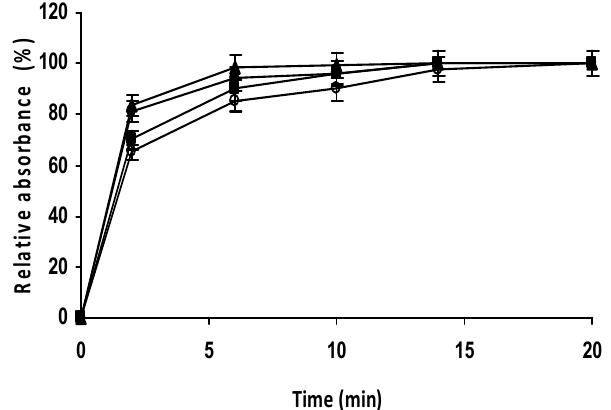
Figure 14. Operational stability of rAaeUPO immobilized on MANAE support. The reaction was performed for 20 min in 5 mM sodium acetate containing 0.03 mM ABTS and 0.125 mM hydrogen peroxide at pH 5.0, re-suspending the biocatalysts in a proportion of 1 g in 100 mL of buffer. The experiment was performed as described in the Methods section. The 100% absorbance was defined as the maximum absorbance achieved in the first cycle. Full circles: first reuse. Full triangles: third reuse. Full squares: sixth reuse. Empty circles: 10th reuse.